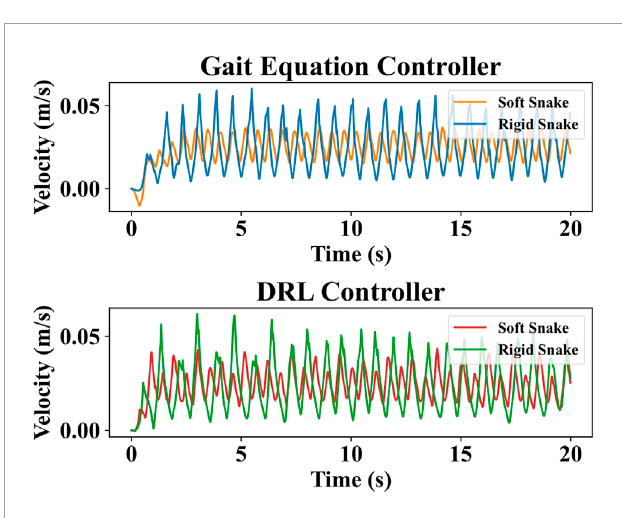
FIGURE 9 Comparison of the center-of-mass velocities of the four gaits.